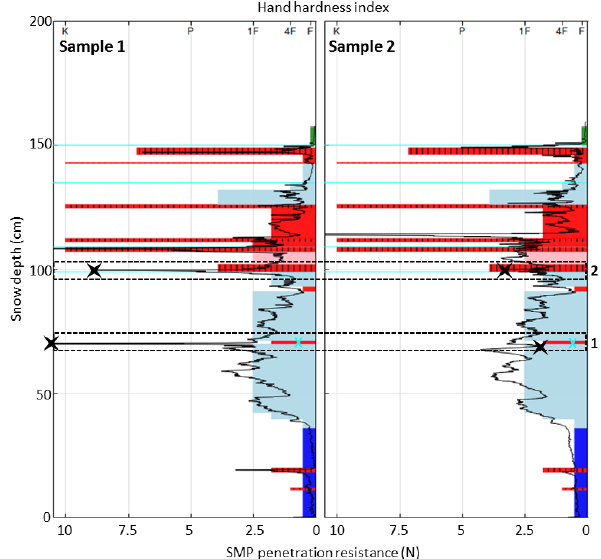
Figure 8. Two samples of SMP profiles of 4 April 2017 (black line) superimposed on the traditional snow profile of the same date. Col- ors referring to the grain shape and hand hardness index are de- fined accordingly to the classification of Fierz et al. (2009). Cyan crosses indicate ice lenses. Dashed rectangles highlight layers 1 and 2. Black crosses indicate the penetration resistance picked for each